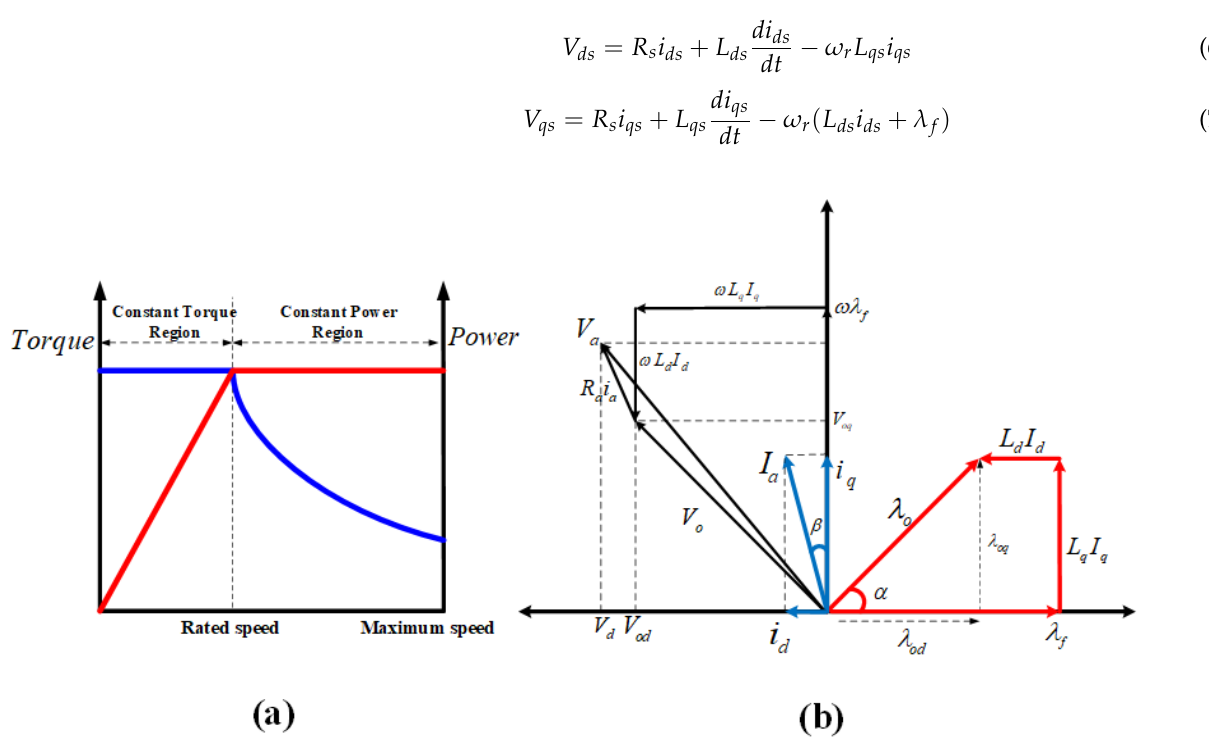
Figure 3. IPMSMs operating region and vector diagram: ( a ) characteristic of IPMSMs and ( b ) vector diagram according to d- and q-axis.